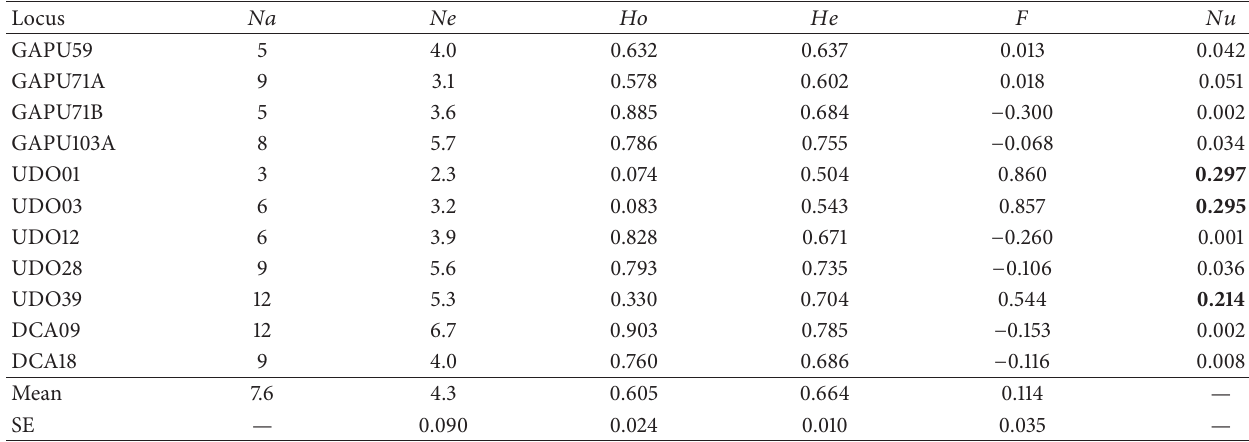
The presence of null alleles are indicated in